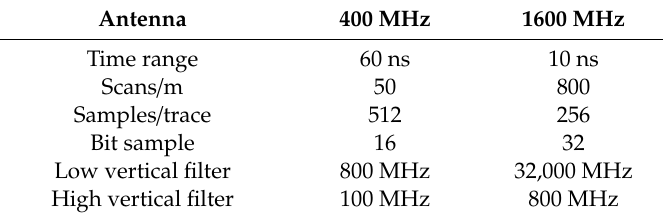
Figure 7. The upper left image shows the 400 MHz antenna, which was used in this study to generally inspect below the mosaic. In the upper right image shows the 1600 MHz antenna, which was used to conduct a detailed 3D inspection of the mosaic. The lower image corresponds to the orthomosaic of the corridor where the inspected rectangles were placed; in yellow, the area of the 2D ground penetrating radar (GPR) profiles; and in black, the 3D-GPR area with parallel profiles spaced 0.05 m apart. Table 1. Most significant acquisition